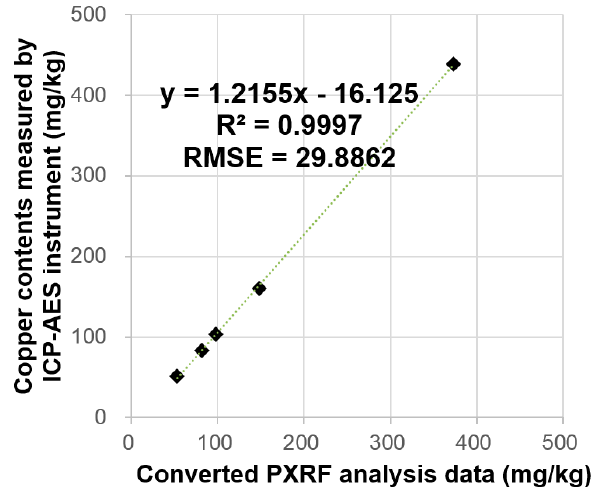
Figure 11. Plot showing correlation between transformed PXRF analysis values and ICP-AES analysis values for the five validation samples.